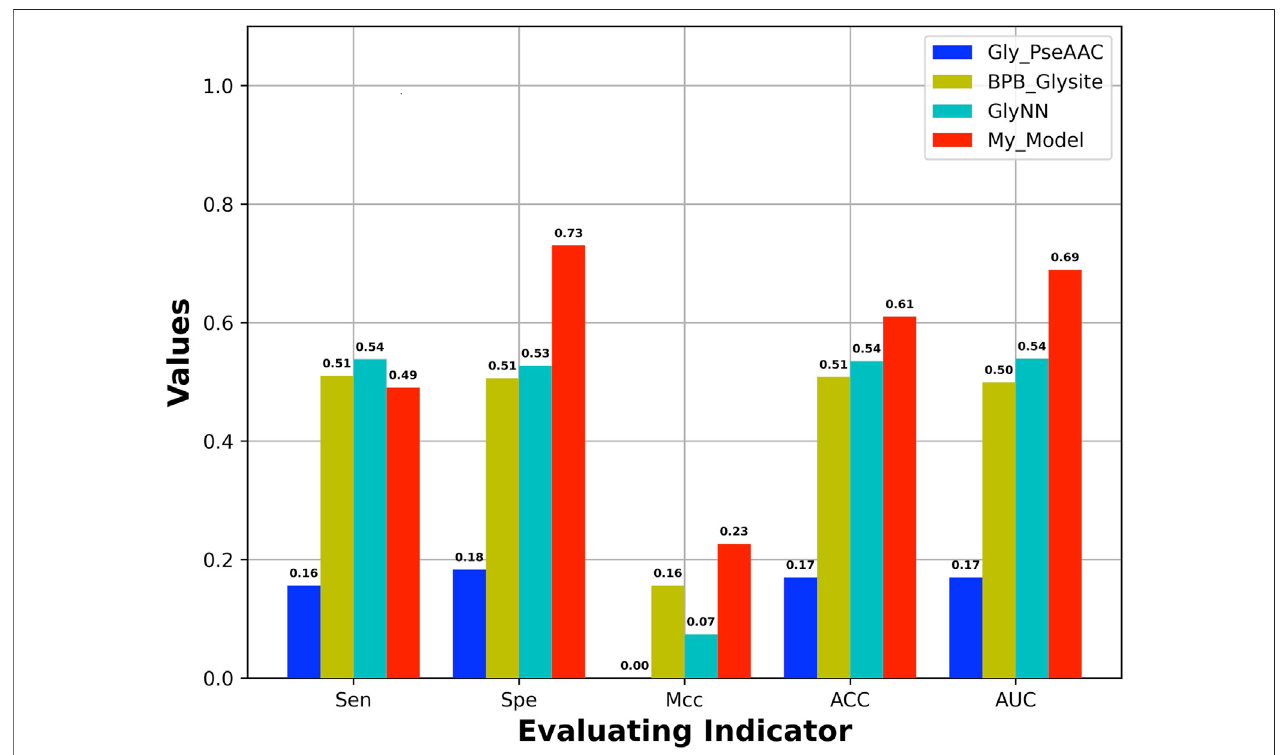
FIGURE 4 | Performance of our model and other existing models based on independent test